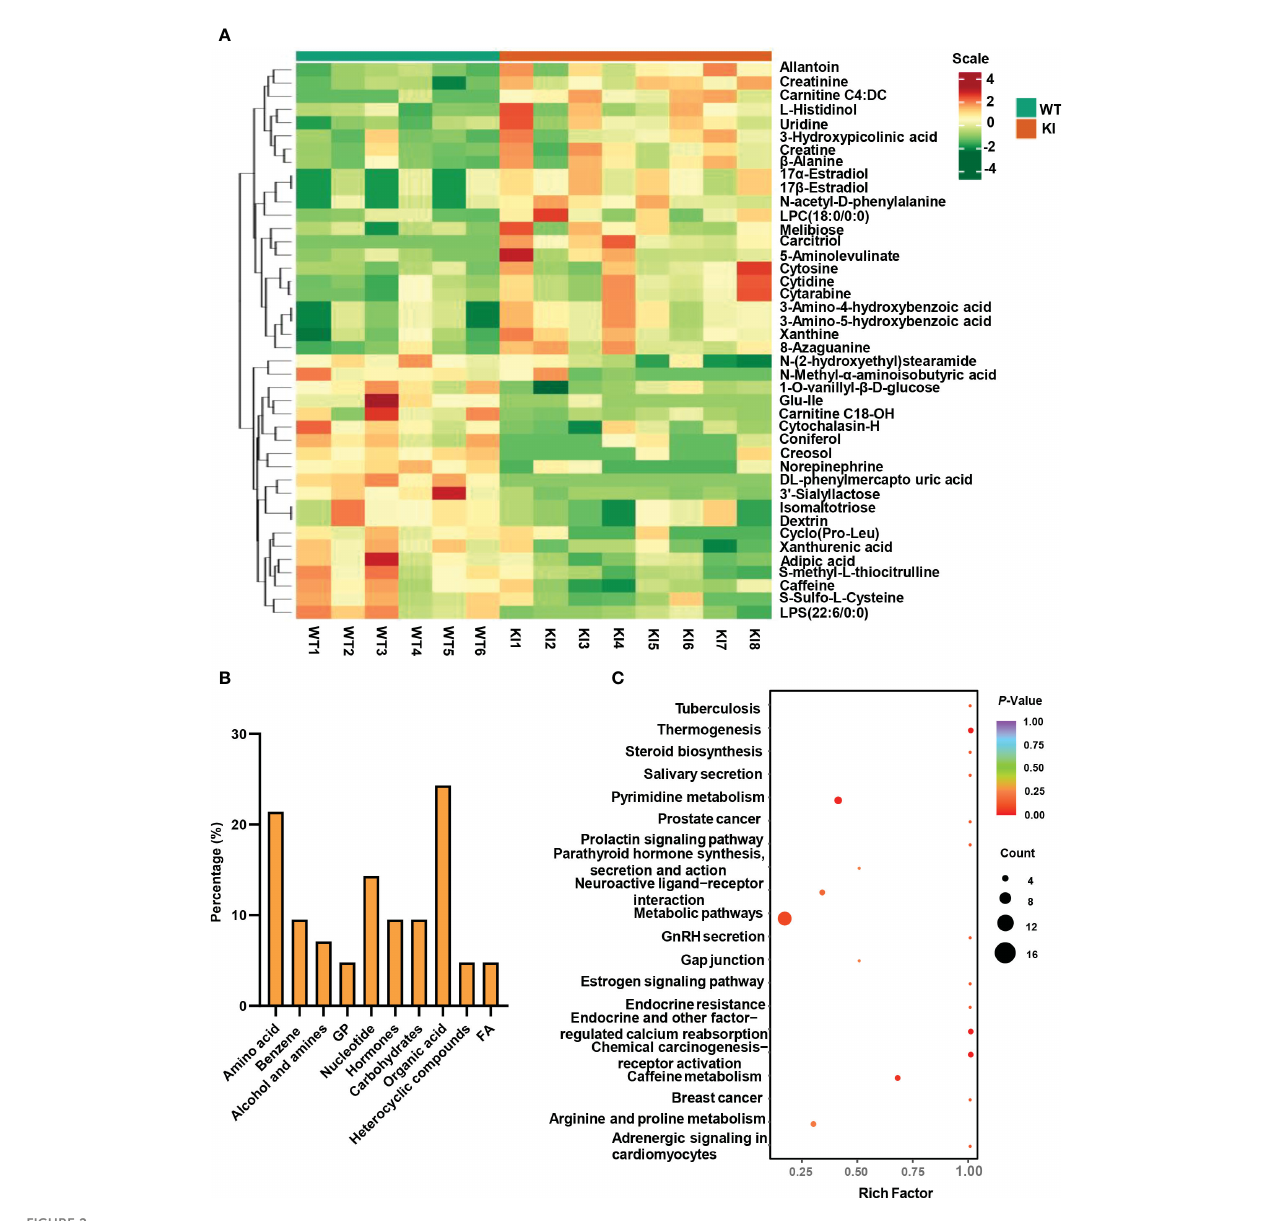
FIGURE 2 Metabolite analysis of Ano5 +/+ and Ano5 KI/KI mCOBs. (A) Heat map showing abundances of metabolites with signi fi cant differences between Ano5 KI/KI and Ano5 +/+ mCOBs. Each row represents a sample, and each column represents a metabolite. Orange shows high expression levels and green represents low expression levels. (WT: Ano5 +/+ ; KI: Ano5 KI/KI ); (B) Bar plot of classi fi cation of detected metabolites into major functional classes; (C) Metabolic pathways enriched in Ano5 KI/KI mCOBs compared to Ano5 +/+ mCOBs. Each bubble represents a metabolic pathway and the size indicates the number of associated metabolites. Different levels of signi fi cance are symbolled by the color